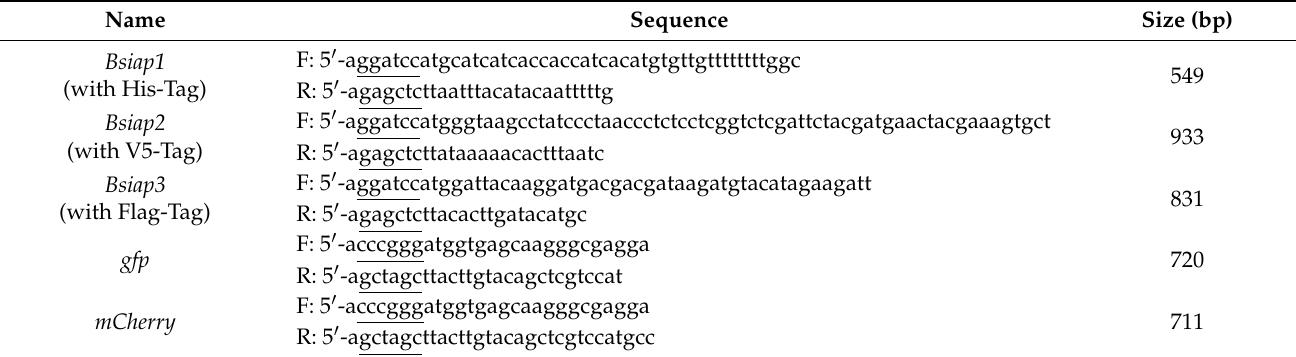
Table 1. Primers used to amplify target